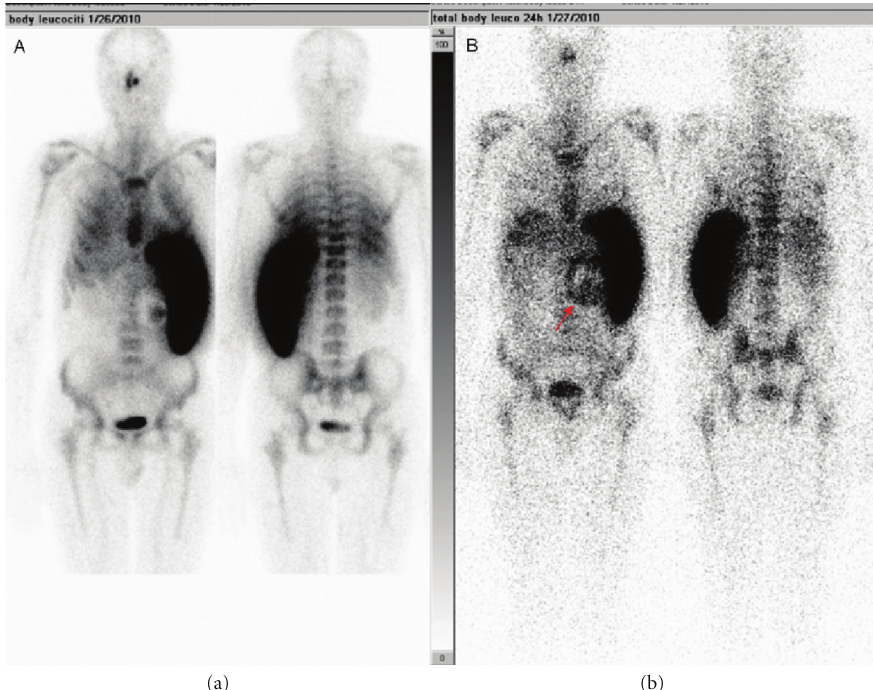
Figure 4: Tc-99m labelled white cells scintigraphy showing a progressive accumulation of circular leucocytes (90 × 90 mm) with sonolucent halo surrounding the aneurysm